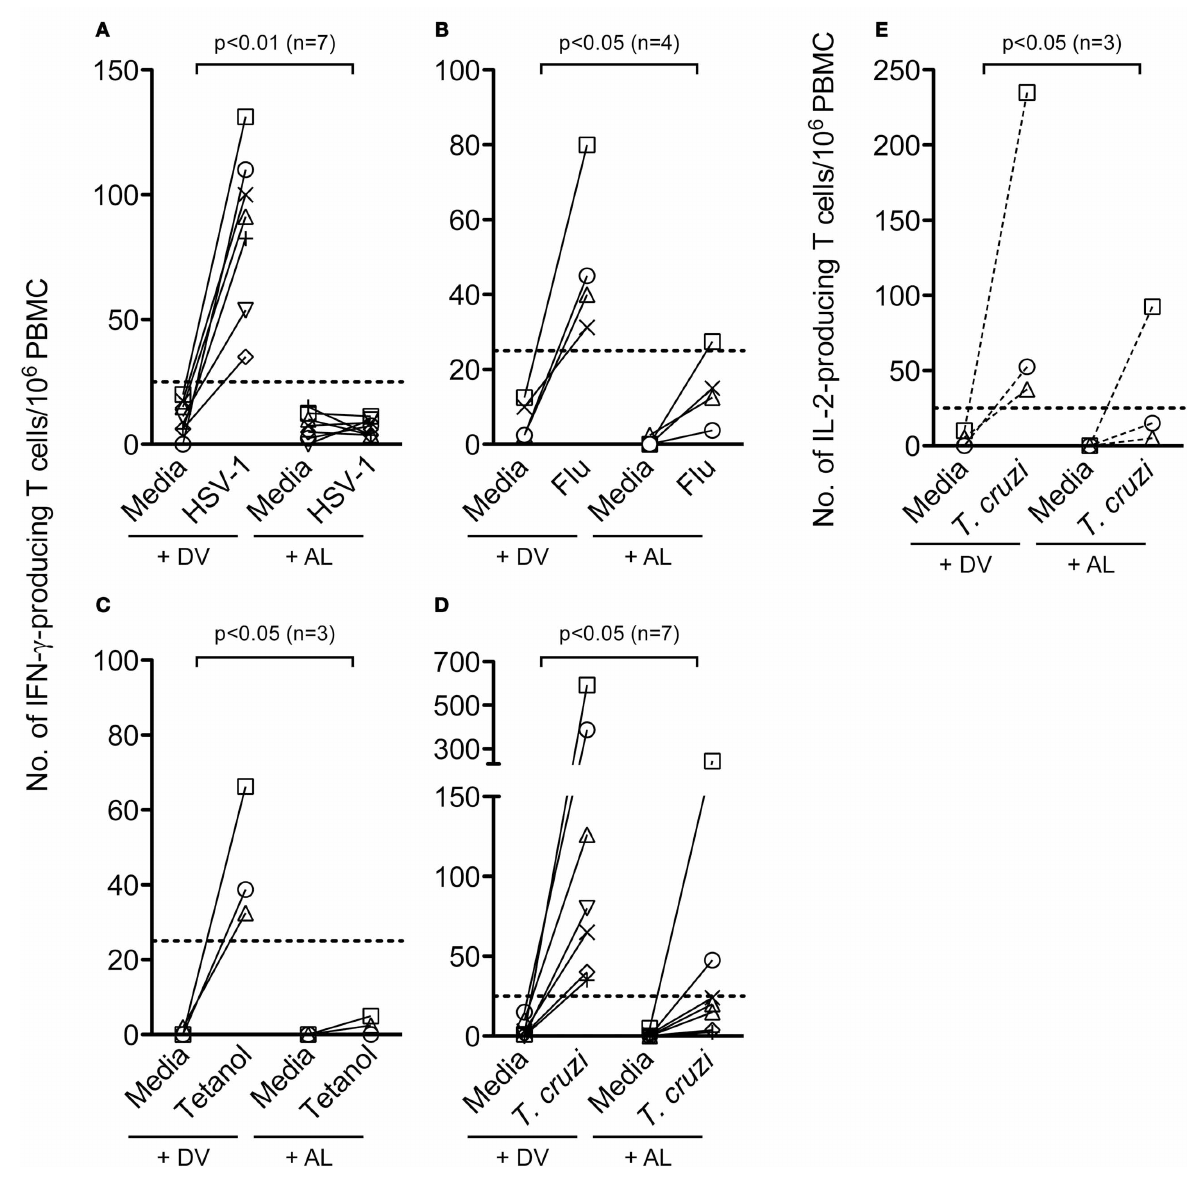
determinedby ex vivo ELISPOT assays. PBMC from a groupof chronically T. cruzi -infected subjects were stimulated with a T. cruzi -derived amastigote lysate (D and E) . Each line representsan individual subject. Dotted lines representthethresholdforpositiveTcellresponses,asdefinedinMaterialsand Methods.Comparisonsbetween T cell responsesin the absence or presence of allopurinol uponstimulation were performedby Wilcoxon signed rank